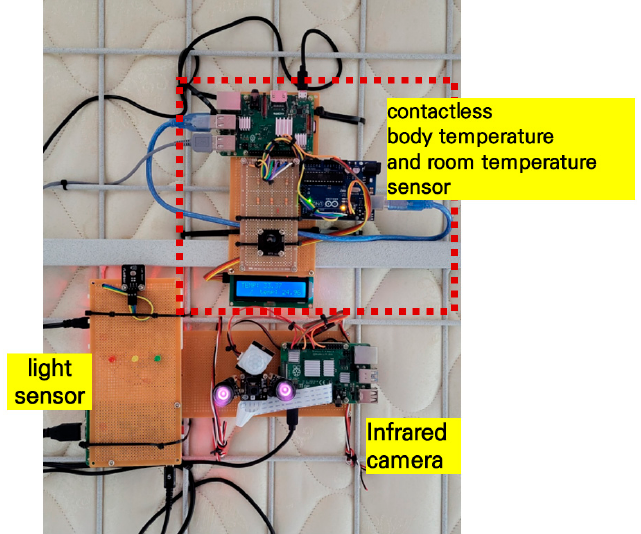
Figure 6. Set of three sensor modules attached to the ceiling.